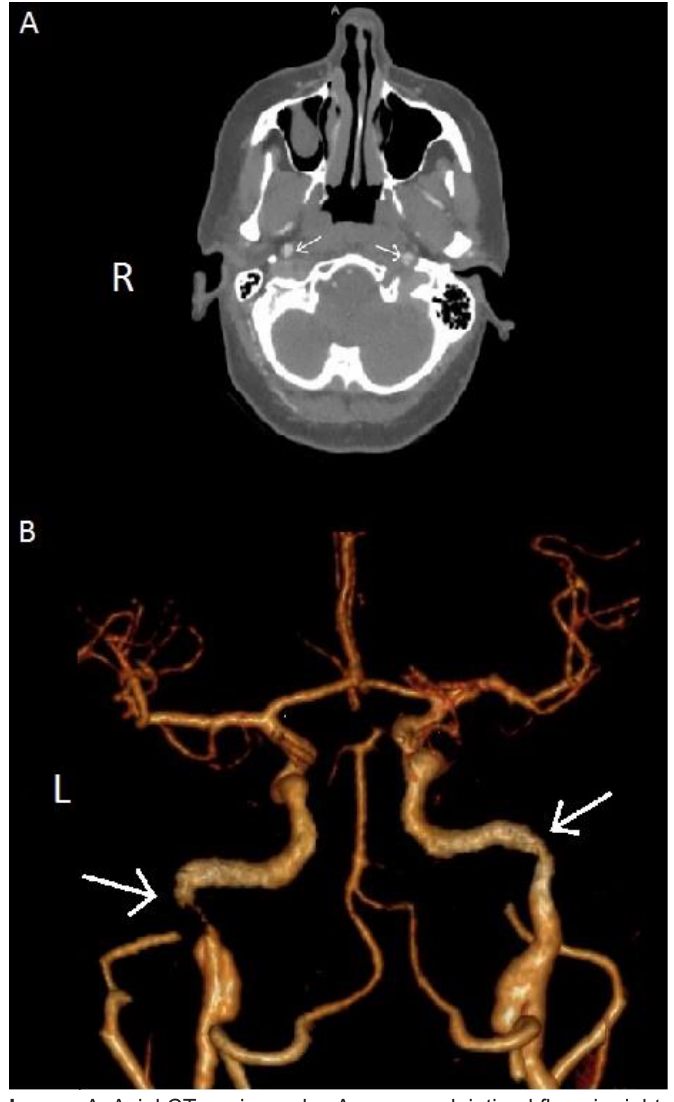
Image. A. Axial CT angiography. Arrows mark intimal flaps in right and left internal carotid arteries. B. 3D reconstruction of CT an- giography of the brain with luminal narrowing of bilateral internal carotid arteries marked by arrows. CT, computed